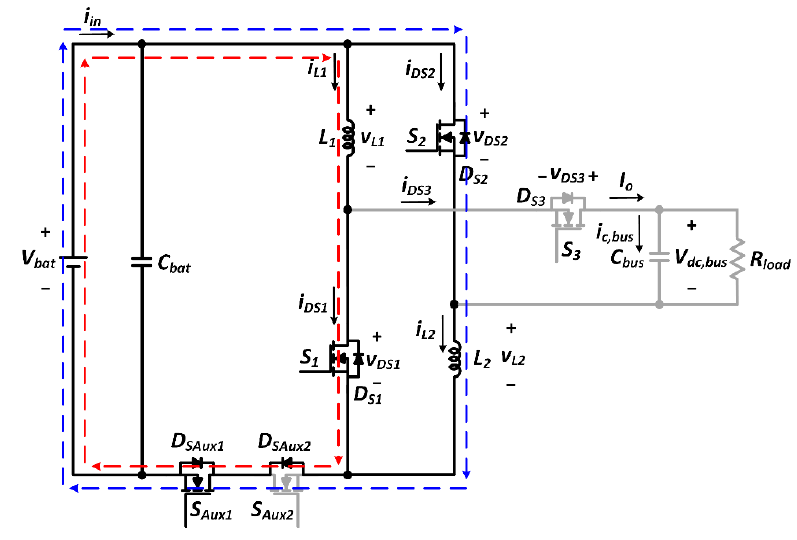
Figure 5. The current flow paths of step-up Mode I.